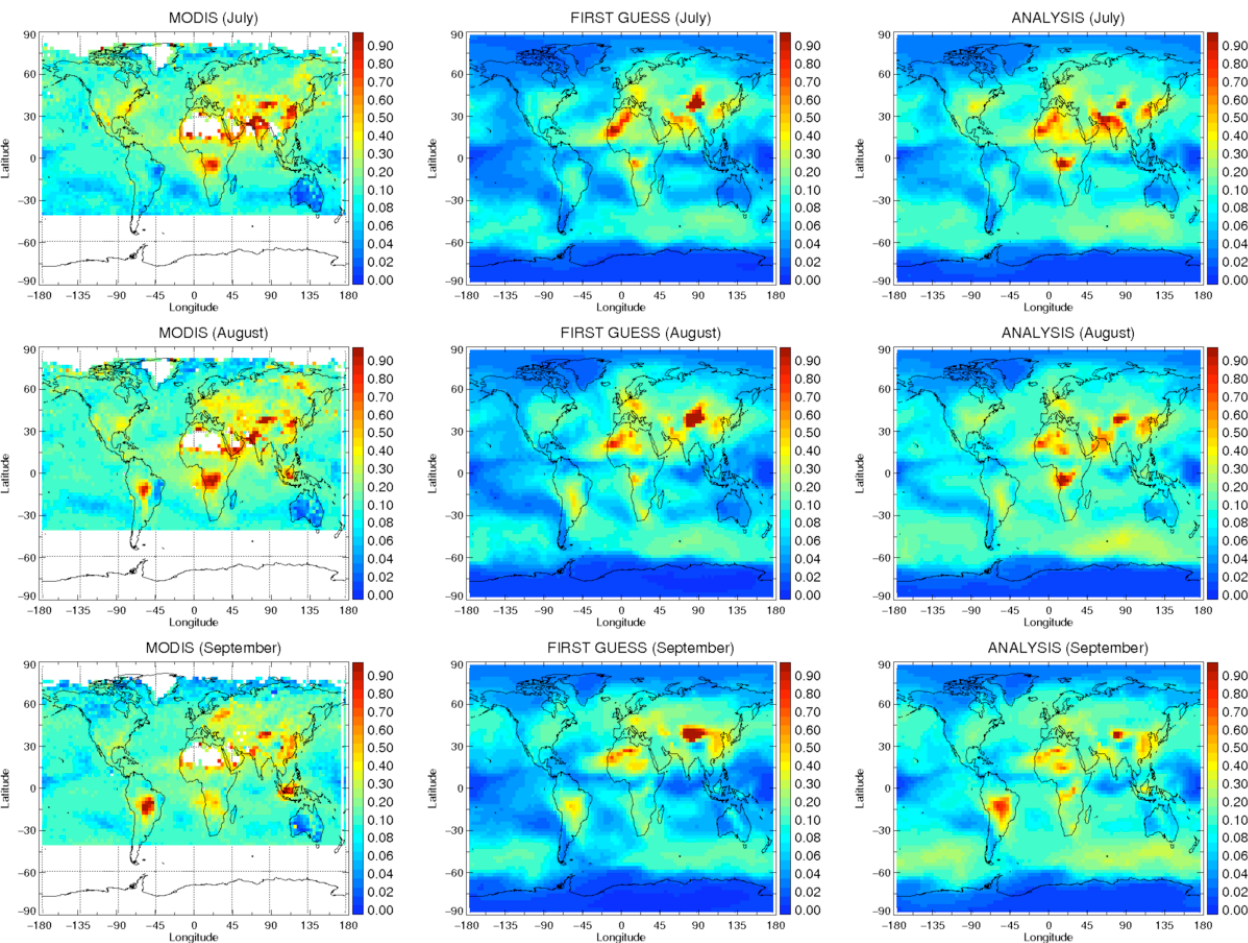
Figure 3. Fig. 3. Total AOD from MODIS (left), first guess (centre) and analysis (right) for the months of July (upper row), August (middle row) and September (lower row) of 2002. White colour corresponds to regions without data. Red colours indicate relatively high values while blue colours indicate relatively low